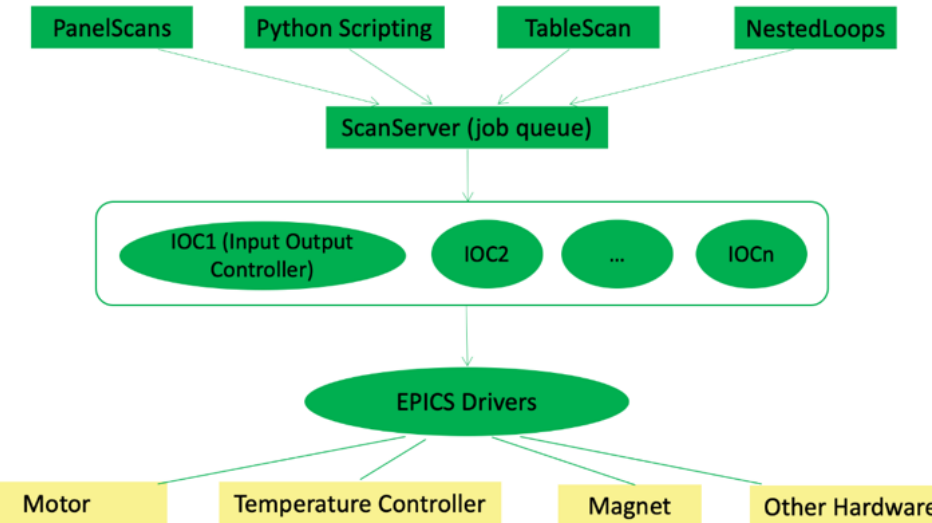
Figure 3. Experimental Physics and Industrial Control System (EPICS) architecture (NestedLoops is a generic graphic user interface tool that was previously developed to build scan jobs with simple nested loops logic. It aims for general use and thus retains a simple design. It can be commissioned if needed.).